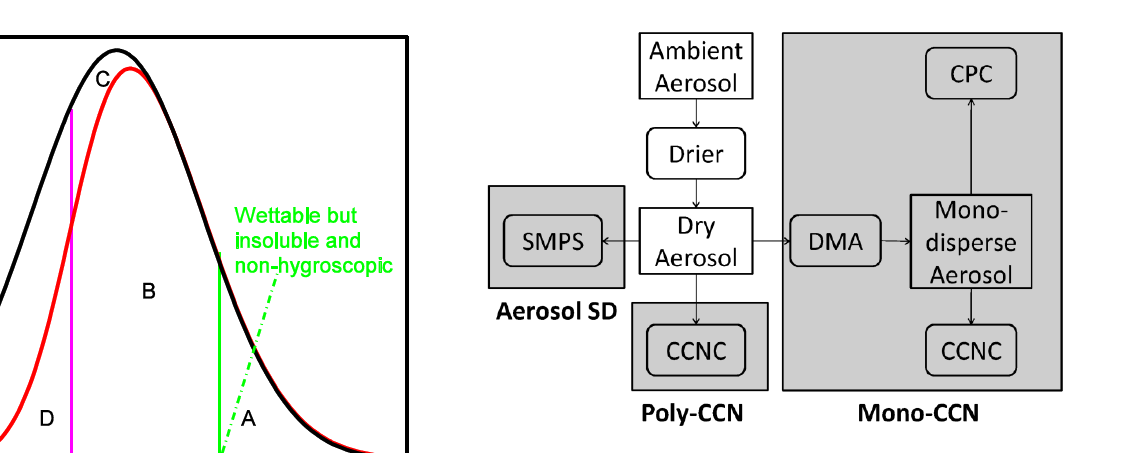
Fig. 3. Instrumentation